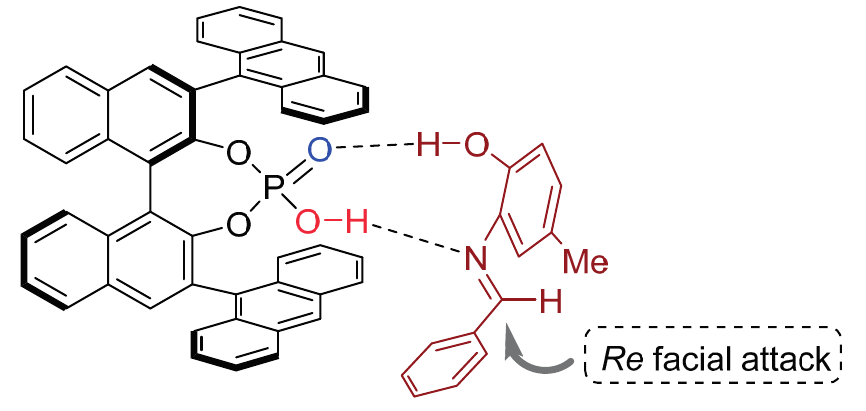
Figure 5. Proposed nine-membered cyclic transition state; the arrow indicates Re facial